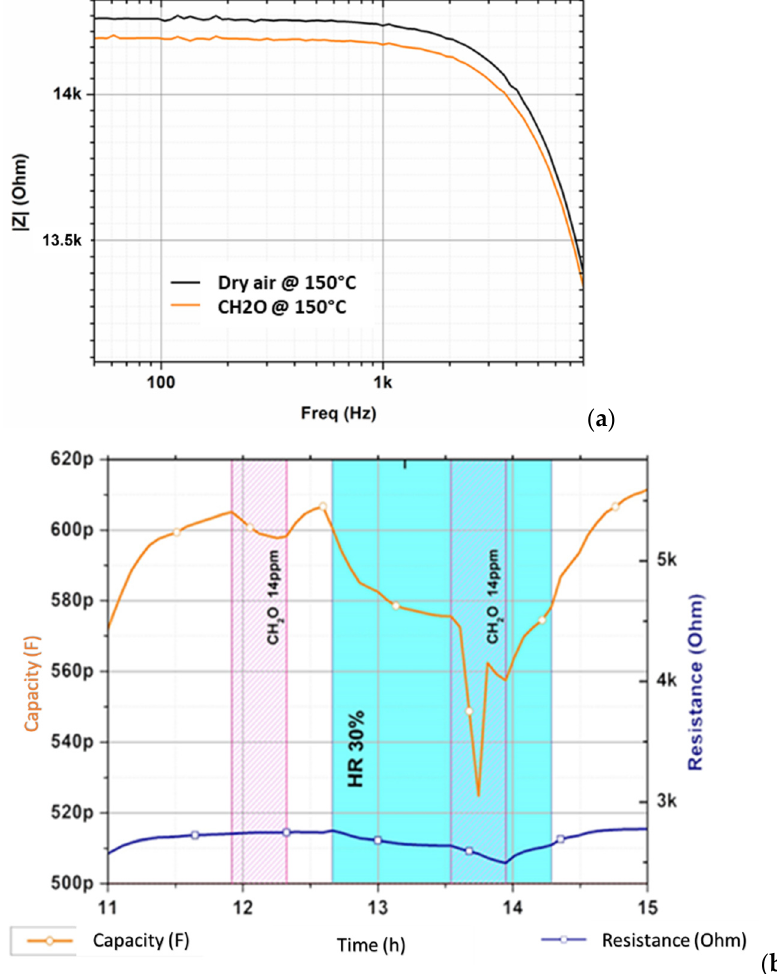
Figure 13. Results of dynamic tests under the same atmospheres versus in static test: ( a ) impedance at low frequencies; ( b ) resistance and capacitance at 10 kHz.